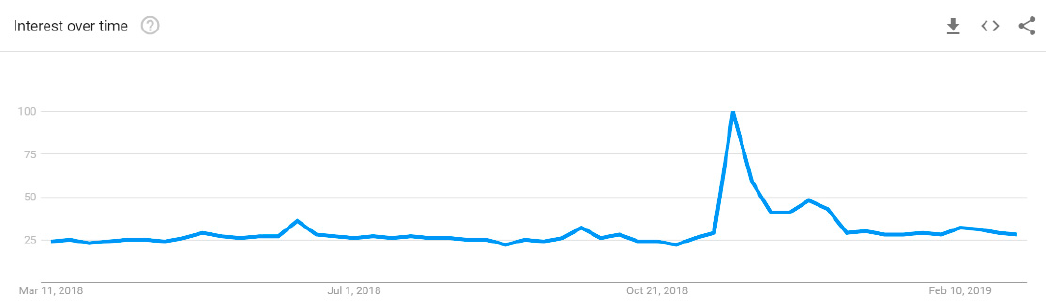
Figure 4. Google Trends for selected luxury fashion brands (January 2004–February 2019) (Data Source: Google Trends, 20 February 2019).